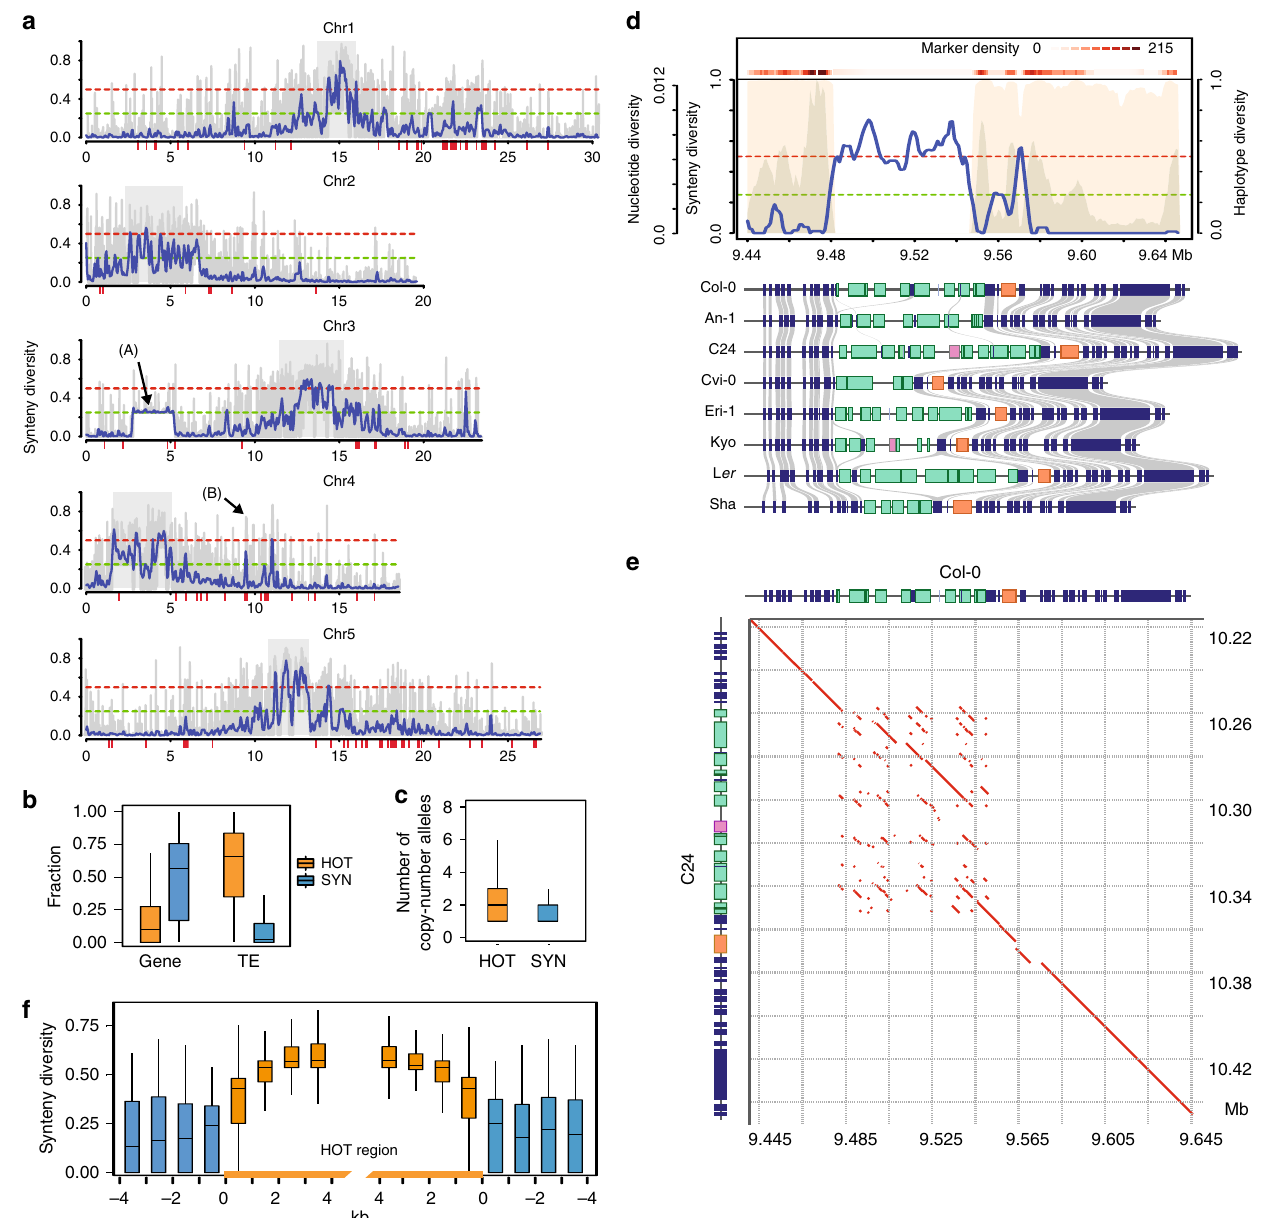
Fig. 3 Quantitative analysis of synteny reveals hotspots of rearrangements. a Synteny diversity along each chromosome: (100 kb sliding windows with a step-size of 50 kb in blue; 5 kb sliding windows with a step-size of 1 kb in grey). Red bars: R gene clusters. Gray rectangles: centromeres. The dashed green and red lines indicate thresholds for synteny diversity values of 0.25 and 0.50. The labelled arrow (A) indicates a 2.48 Mb inversion in the Sha genome. The labelled arrow (B) indicates the location of the example shown in d . b Gene and TE densities in 10,331 syntenic (SYN) and 576 hotspots of rearrangements (HOT) regions. c The number of variable copy-number alleles in 10,331 syntenic (SYN) and 576 rearrangements (HOT) regions. d An example of a HOT region including the RPP4/RPP5 R gene cluster. The upper panel shows the distribution of synteny diversity (blue curve), nucleotide diversity (gray background) and haplotype diversity (pink background) in a 5 kb sliding window with a step-size of 1 kb. Both the nucleotide diversity and the haplotype diversity were calculated based on informative markers (MAF ≥ 0.05, missing rate < 0.2) from the 1001 Genomes Project 8 . The marker density is shown as the heatmap on top. The green and red dashed lines indicate the value 0.25 and 0.50 of synteny diversity, respectively. The schematic in the lower part shows the annotated protein-coding genes (colored rectangles). Blue rectangles: non-resistance genes. Other colored rectangles: resistance genes where genes with the same color belong to the same gene family. The gray links between the rectangles indicate the homologous relationships between non-resistance genes. e A dot plot of Col-0 and C24 sequence from the HOT region shown in d . Red lines: homologous regions between the two genomes. f The distribution of synteny diversity values in 1 kb sliding windows around and in 576 HOT regions. In box plots b, c and f , centre line: median, bounds of box: 25th and 75th percentiles, whiskers: 1.5 * IQR (IQR: the interquartile range between the 25th and the 75th percentile). Source Data are provided as a Source Data fi